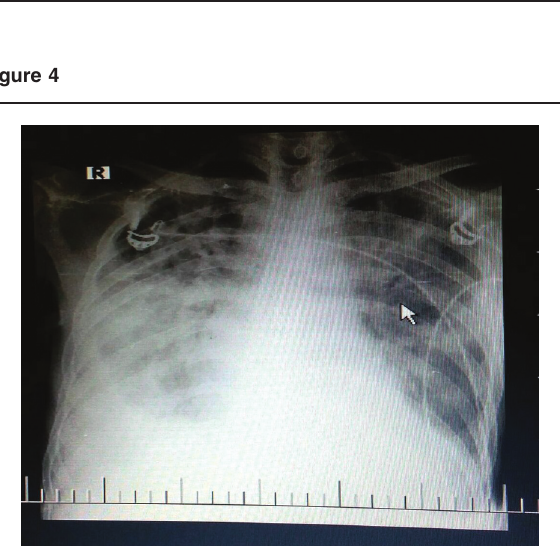
Chest radiograph showing cardiomegaly with bilateral alveolar infil- trates.